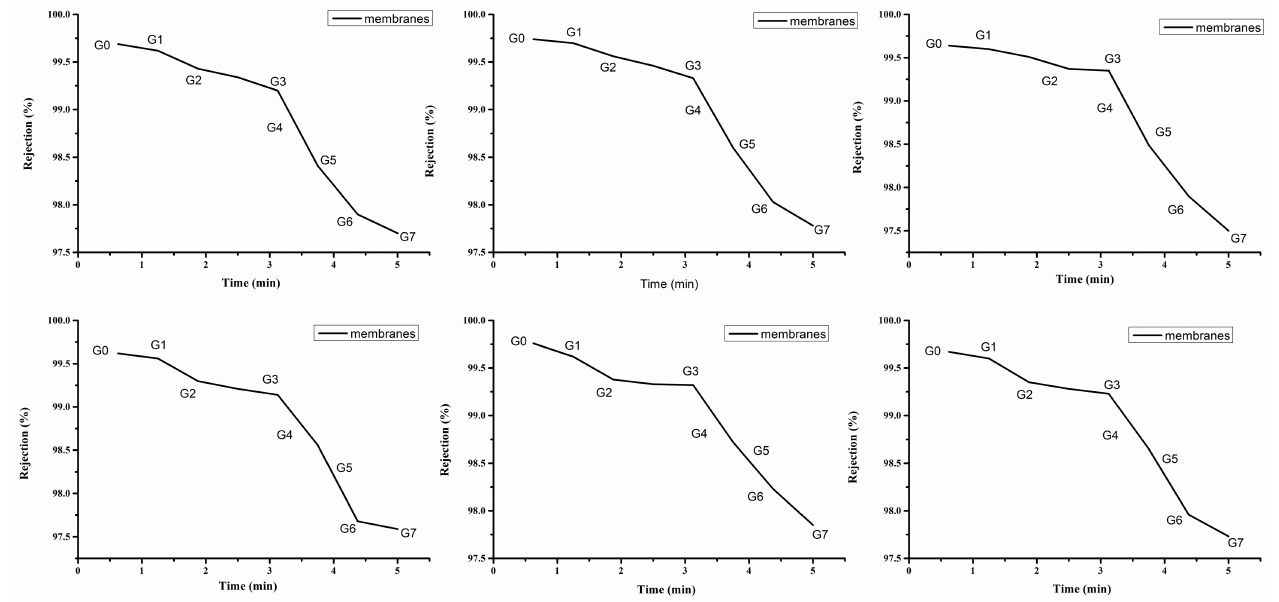
Figure 9. BSA rejection of the PES membranes (from G0 to G7) as a function of